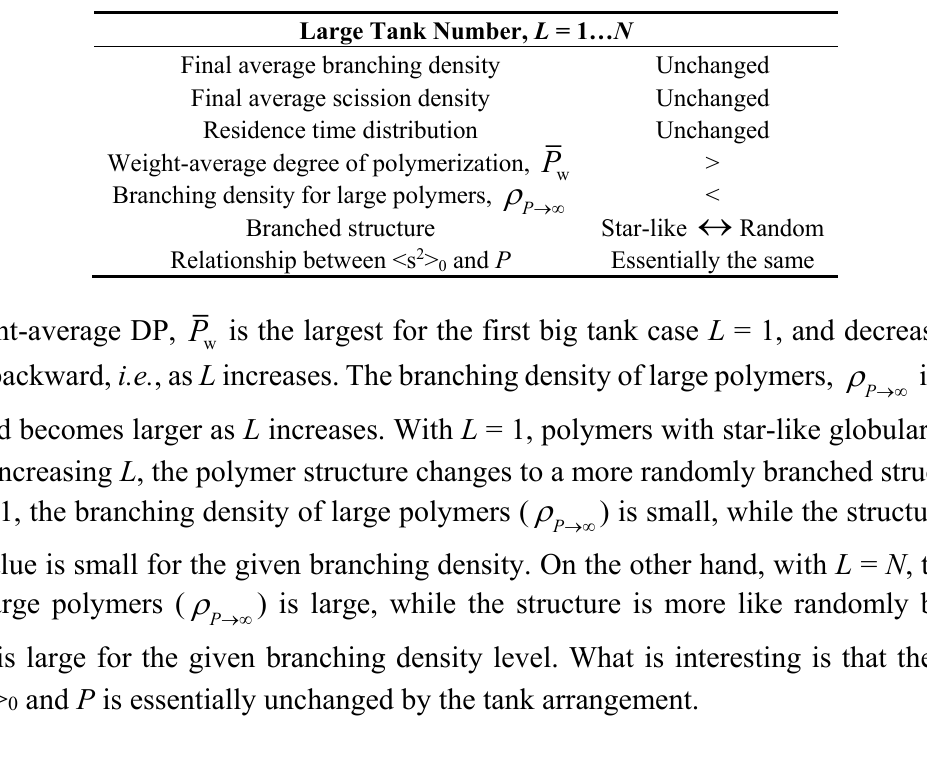
Table 3. N CSTRs in series with one large tank, when the final conversion, x N , is set to be the